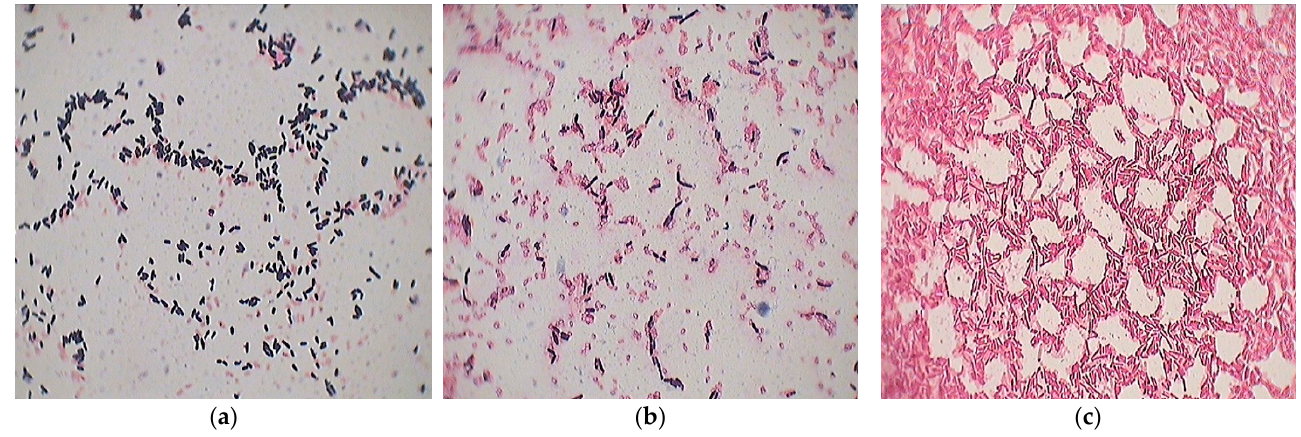
Figure 1. Microscopic aspects of: ( a ) Azotobacter sp.—Gram-positive; ( b ) Bacillus sp.—Gram-positive; ( c ) Pseudomonas sp.—Gram-negative.